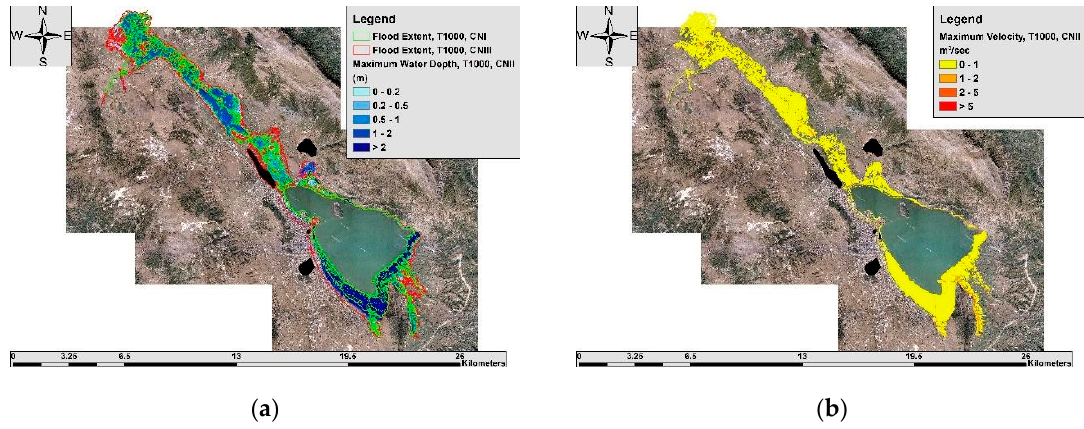
Figure 2. Flood extent and maximum water depths of return period T = 50 years for all examined scenarios ( a ) and simulated maximum velocities ( b ) only for the average scenario.